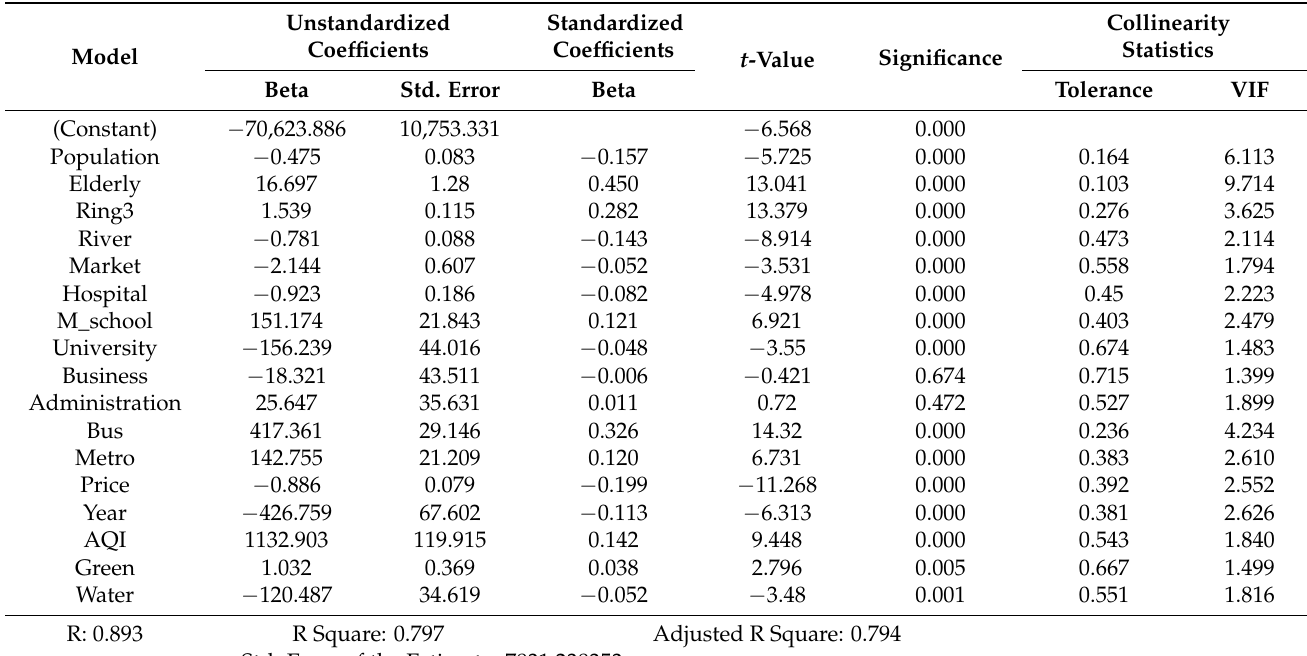
Table 6. Model summary of seventeen urban factors.